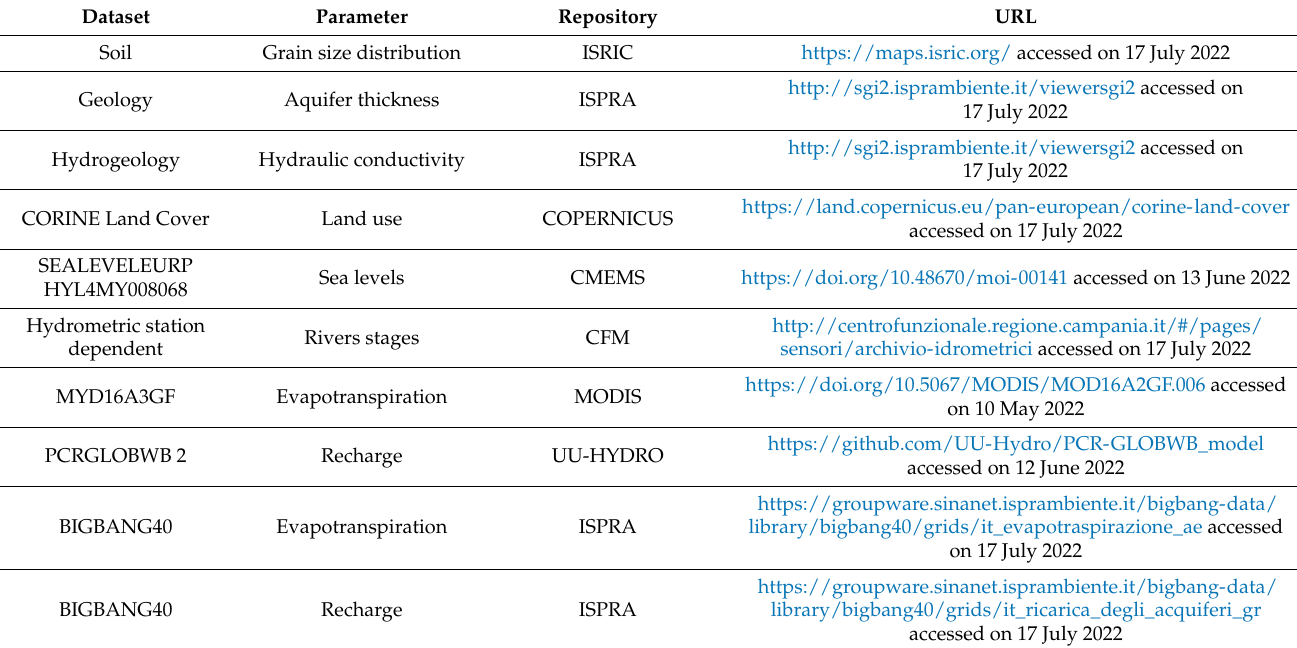
Table 1. National and worldwide open online datasets used to set up the